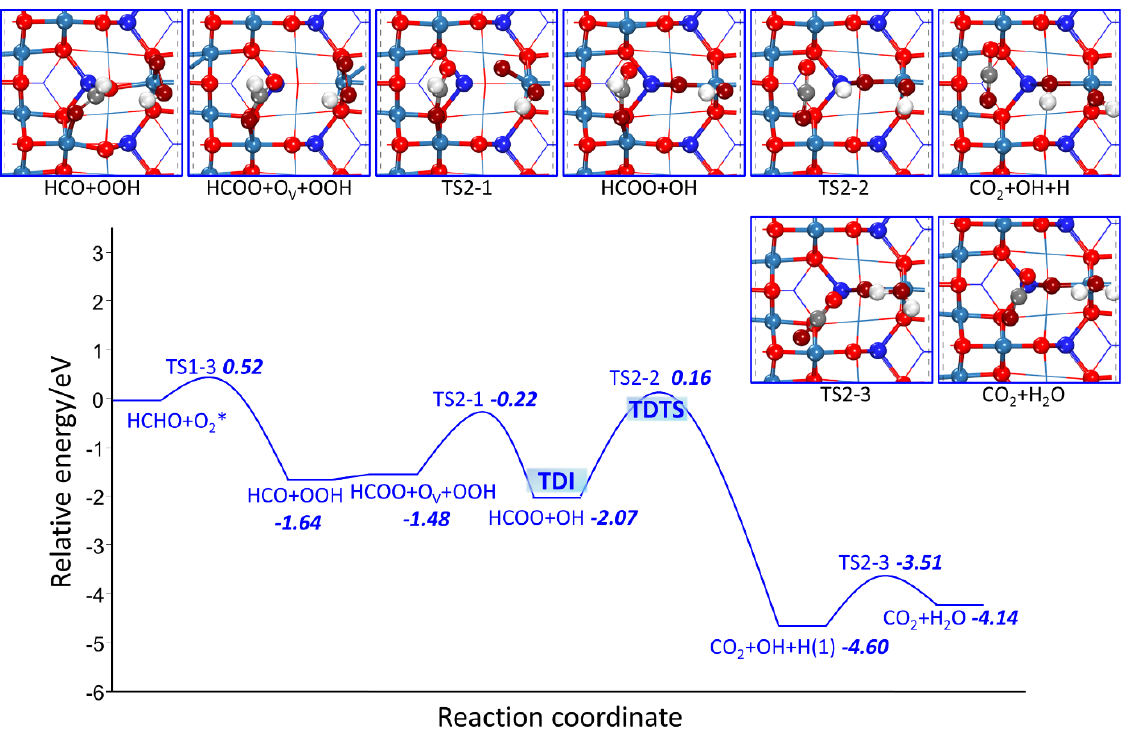
Figure 6. The potential energy profile of HCHO oxidation based on MvK mechanism through HCO grabbing O latt together with the structures of TSs and FSs on Co 3 O 4 (110) surface. Starting from the reaction of CO + H + OOH (R3-2, R3-5), CO binds to O latt for CO 2 formation through TS3-2 and binds to lattice OH for COOH formation through TS3-5 with the activation barrier of 2.02 eV and 5.36 eV, respectively. The two reaction steps are en- dothermic with reaction energies of 1.59 and 1.84 eV, respectively, suggesting the combi- nation of CO with lattice OH for COOH formation is blocked kinetically and thermody- namically. The following O V filling by OOH dissociation through TS3-3 and TS3-6 exhibits the activation barrier of 1.16 eV and 1.80 eV, respectively, which are different from that of R2-1, indicating that OOH dissociation is affected by co-adsorbents. As for the reaction of OH combining with H atom (TS3-4) and the reaction of H atom of COOH transferring to OH for H 2 O formation (TS3-7), their activation barriers are 1.40 eV and 1.24 eV, respec- tively. Starting from the reaction of CO+HOOH, CO reacts with O latt to produce CO 2 , and HOOH dissociates into two OH groups. One OH occupies O V , the other OH reacts with H atom to produce H 2 O. The activation barrier for these three elementary reactions (R3-9, R3-10, R2-3) are 1.85, 1.00, and 1.09 eV, respectively. Through comparing the four reaction paths, the purple line in Figure 7 is the most preferable as the maximum activation barrier of 1.85 eV is much lower than other three paths with the maximum barrier of 4.26 eV.